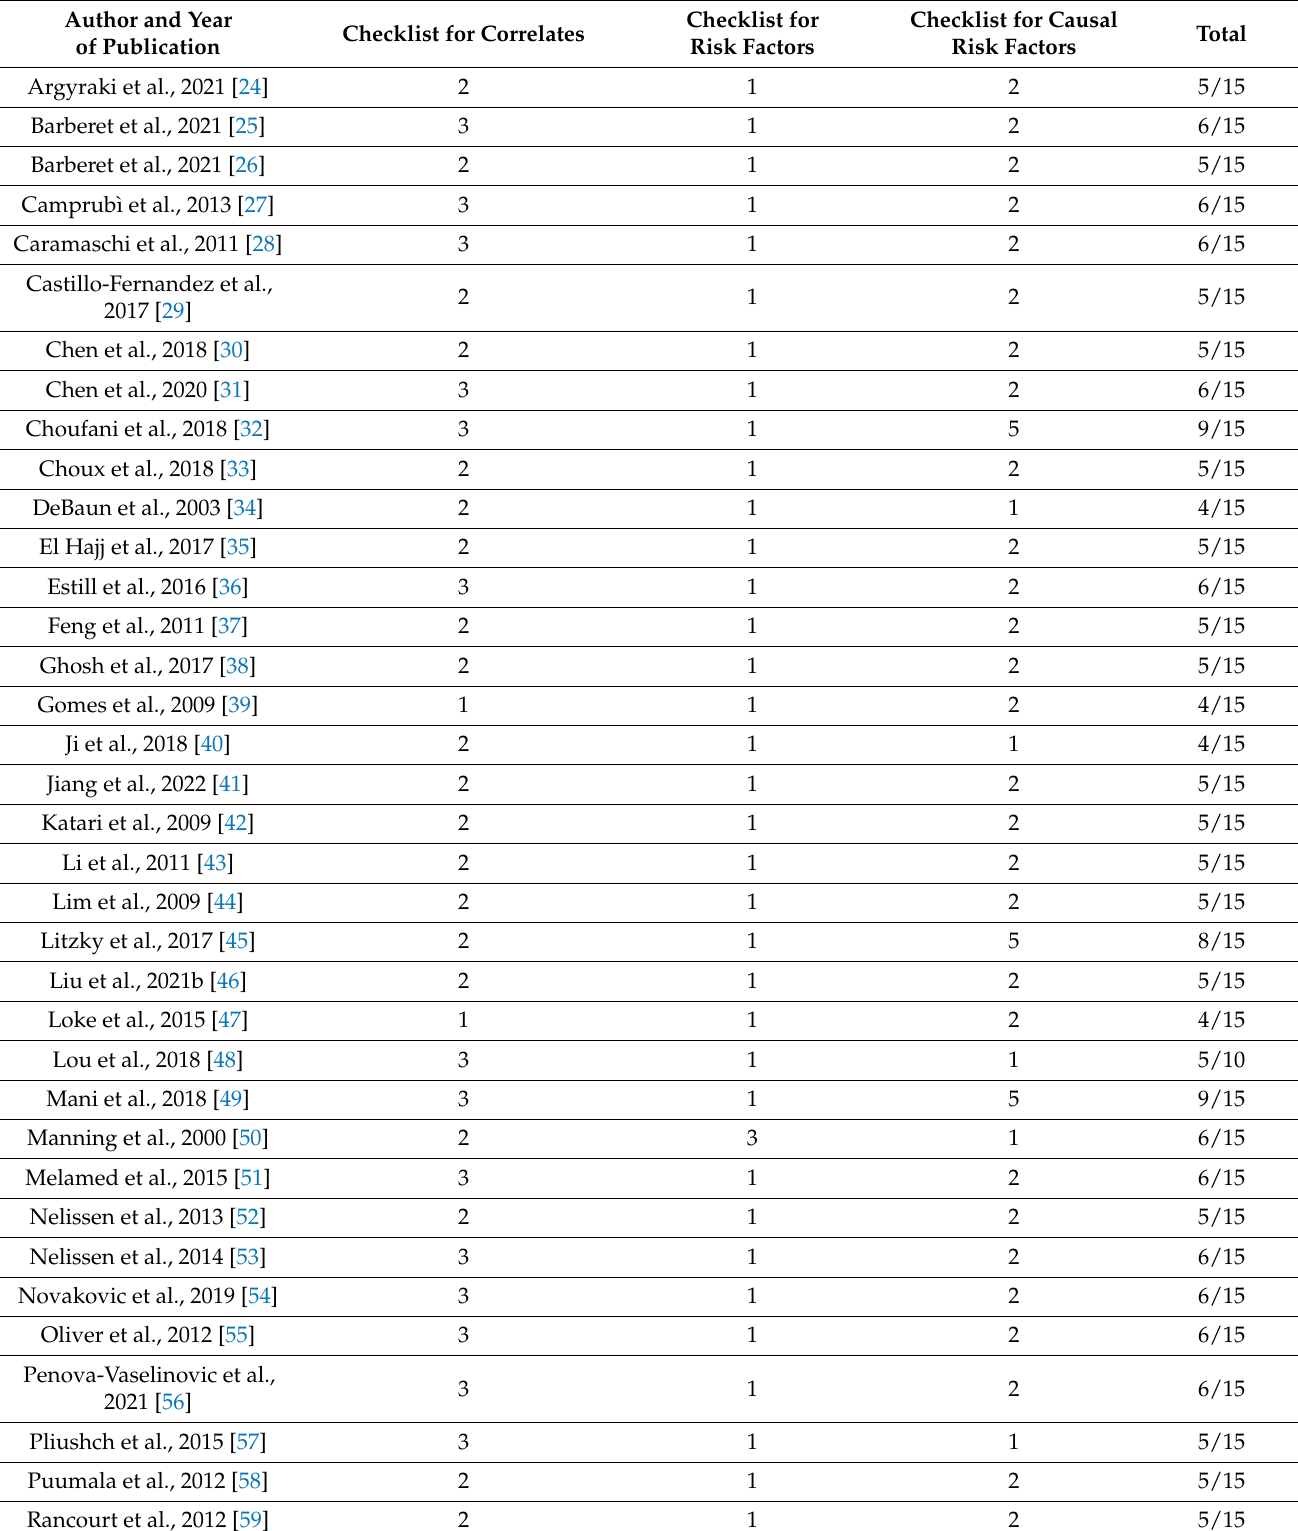
Table 3. Evaluation of study quality using “The Cambridge Quality